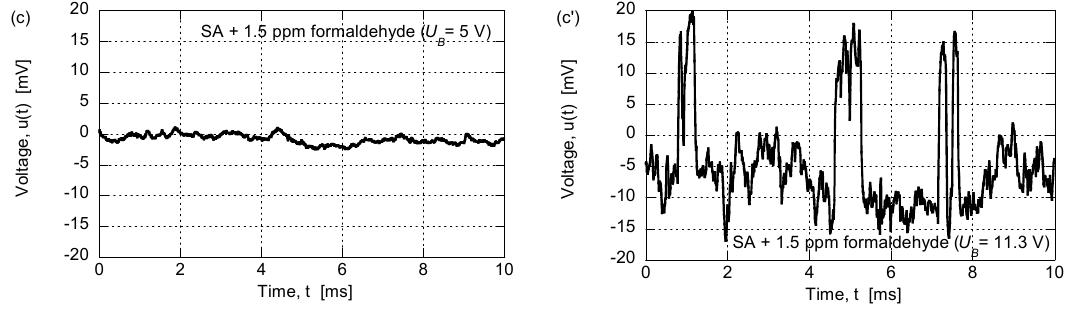
Figure 2. Time-dependent voltage fluctuations u ( t ) across an AuNP-based gas sensor exposed to the shown gases at the stated bias voltages ( U B ).